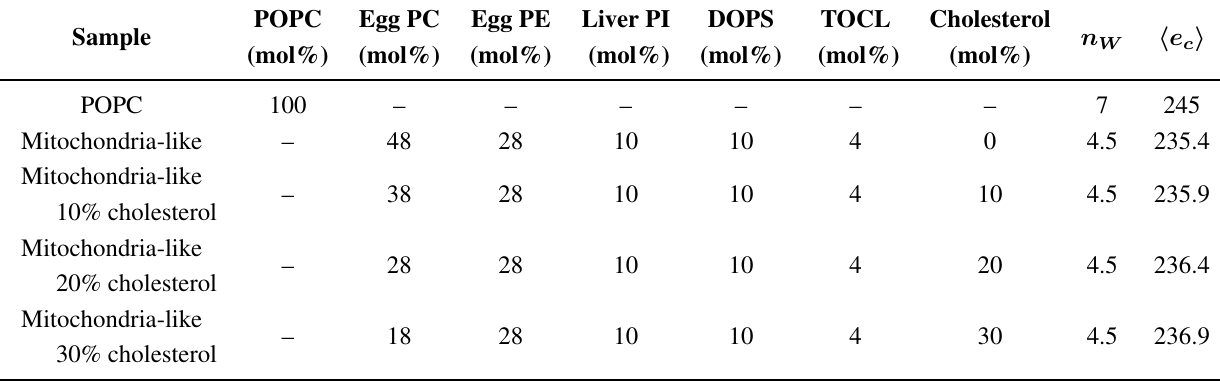
Table 2. Composition of the membranes examined in this study. For each lipid composition, the estimated number of water molecules per phospholipid headgroup, n W , as well as the average number of electron per chain, (cid:104) e c (cid:105) , calculated with Equation (10), as explained in Section 4.5, are indicated. POPC Egg PC Egg PE Liver PI Sample